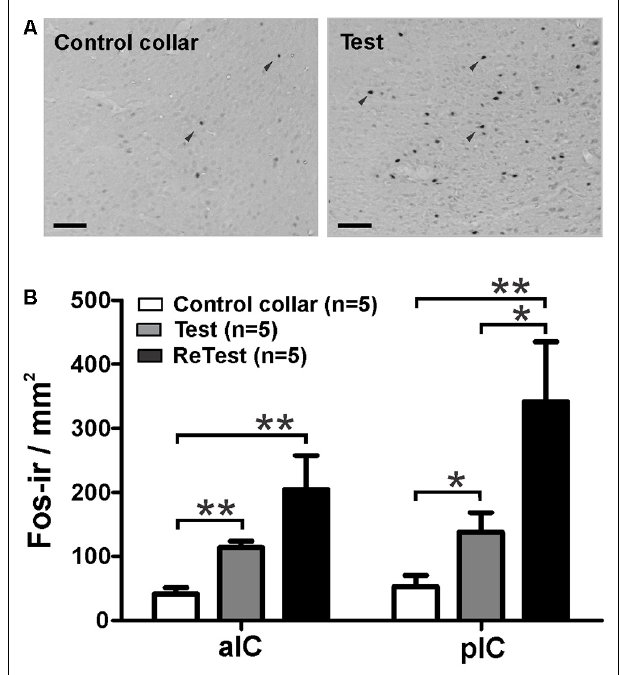
FIGURE 5 | Cat odor exposure increased Fos expression in the insula cortex. (A) Representative photomicrograph of the pIC showing a near absence of Fos immunoreactive (Fos-ir) cells (black arrowheads) in rats exposed to a control collar (left) contrasted with a significant increase in the number of Fos-ir cells in rats exposed to cat odor (right). (B) Quantification of Fos-ir cells in the anterior insula cortex (aIC) and pIC in rats exposed once (Test) or twice (ReTest) to cat odor. Data are expressed as means + SEM. ∗ p < 0.05, ∗∗ p < 0.01. Scale bars, 200 µ